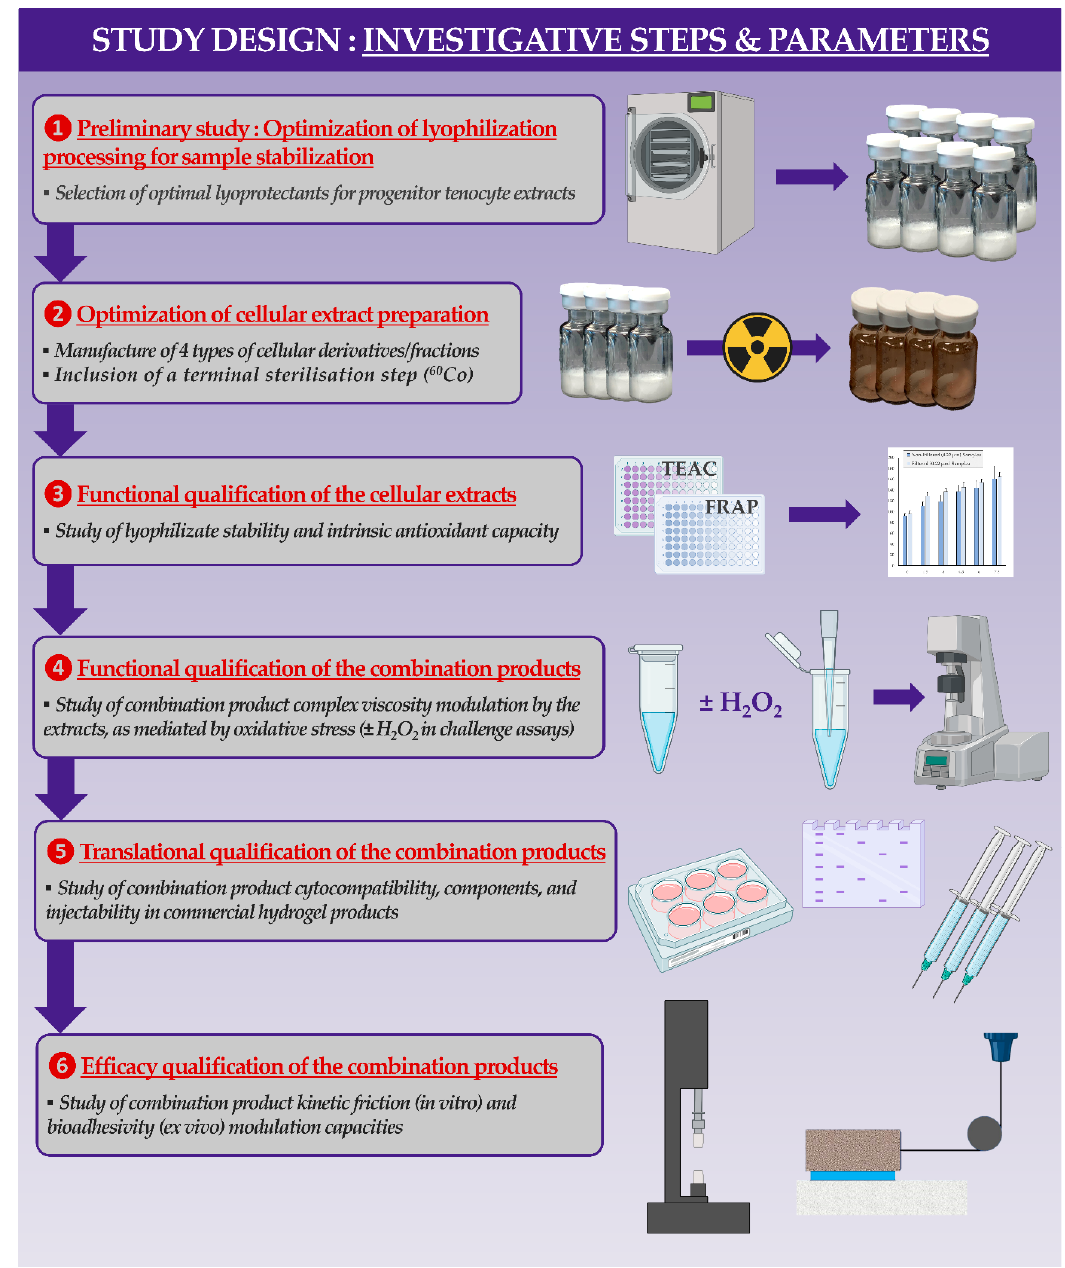
Figure A1. Schematic and illustrated technical overview of the main steps of the present study. The retained approach enabled a translational assessment of the cellular extracts under consideration, ranging from formulation options to ex vivo investigation of HA-containing combination product efficacy-related parameters. Steps 1 and 2 enabled the identification of optimally stable and steriliz- able cellular derivatives. Step 3 enabled the characterization of the intrinsic properties and effects of the lyophilized cellular extracts. Step 4 enabled the study of the effects of the cellular extracts in a hydrogel environment with simulated oxidative stress within H 2 O 2 challenge assays (i.e., mimicking accelerated degradation conditions or a pathological in vivo environment). Steps 5 and 6 enabled the validation of the technical applicability of the extracts and combination products for potential therapeutic management of tendinopathies, based on formulation, preliminary safety, and efficacy- related parameters. FRAP, ferric reducing antioxidant power; HA, hyaluronic acid; TEAC, Trolox equivalent antioxidant capacity.